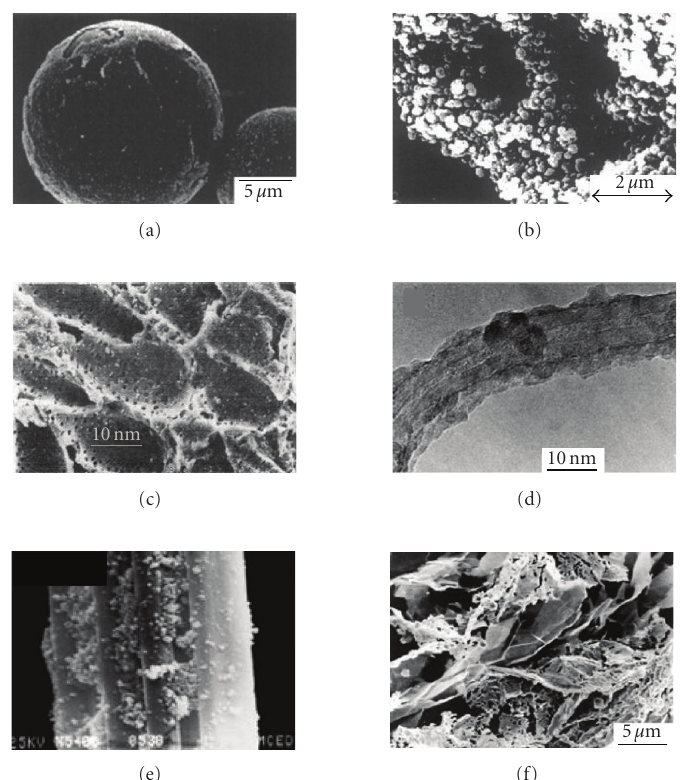
Figure 7: TiO 2 loaded on (a) carbon spheres [28], (b) activated carbon [28], (c) granular activated carbon [35], (d) carbon nanotubes [37], (e) carbon fibers [36], and (f) exfoliated graphite [38].